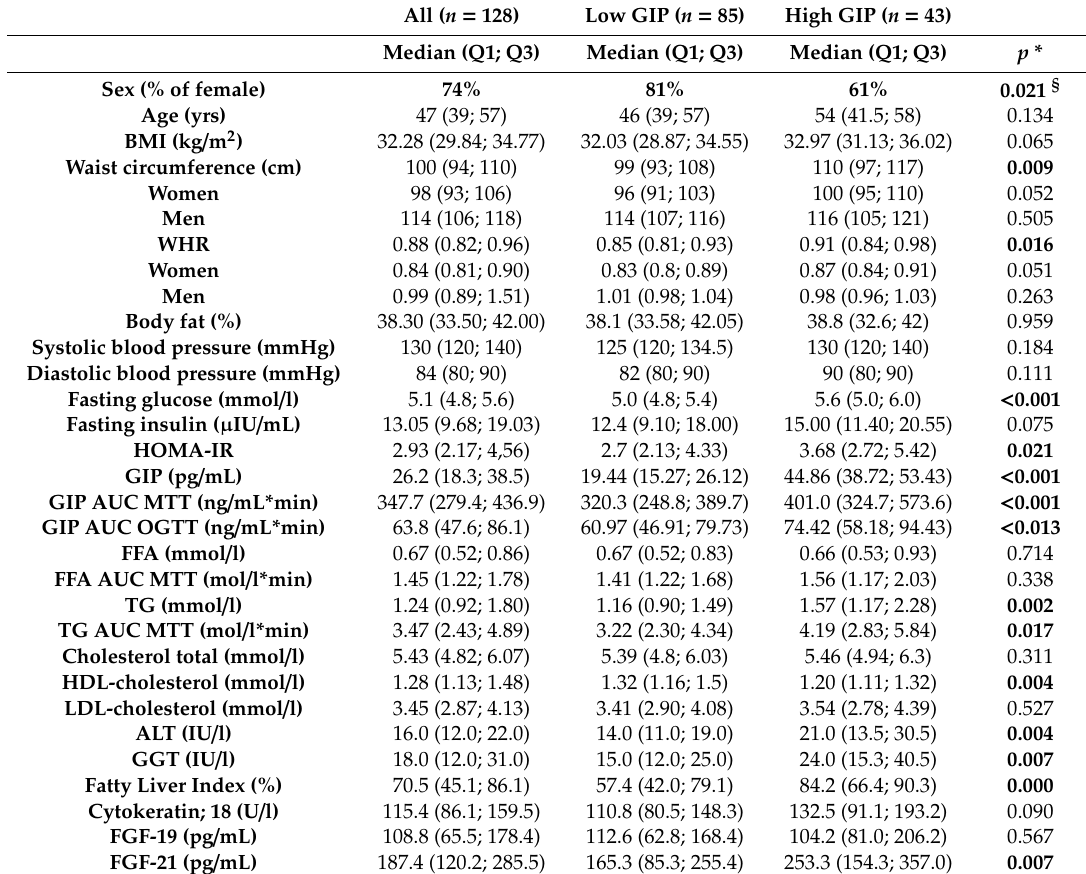
Table 1. Characteristics of subjects included in the study, comparison of groups according to fasting plasma glucose-dependent insulinotropic polypeptide (GIP)